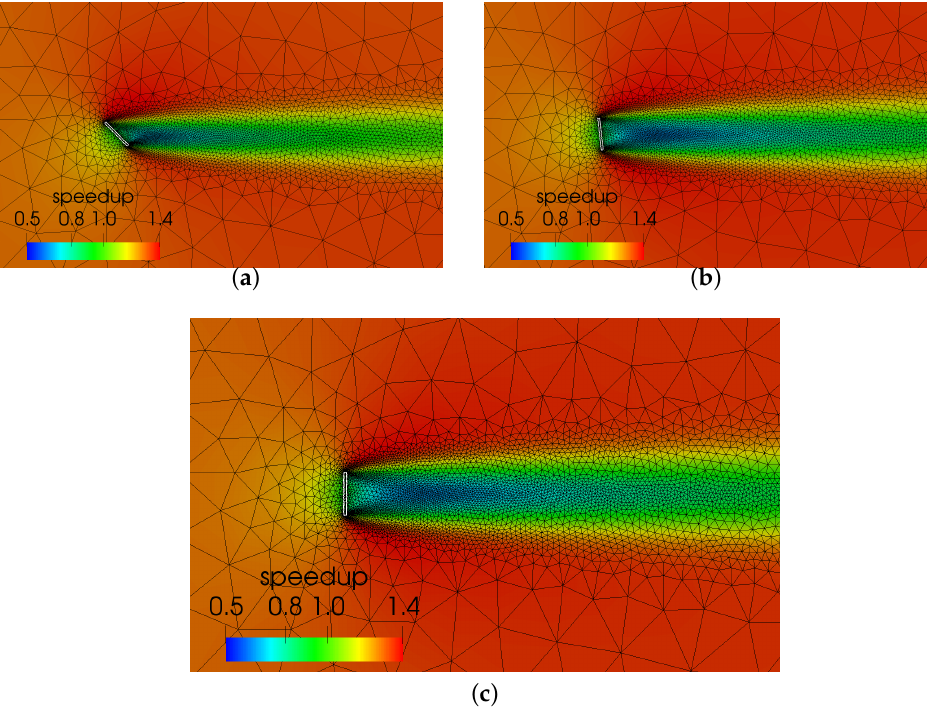
Figure 17. Turbine re-alignment simulation. Adapted meshes for the: ( a ) initial configuration, ( b ) inter- mediate correction, ( c ) final configuration. The meshes are colored according to the wind speedup with respect to the velocity at the hub of the